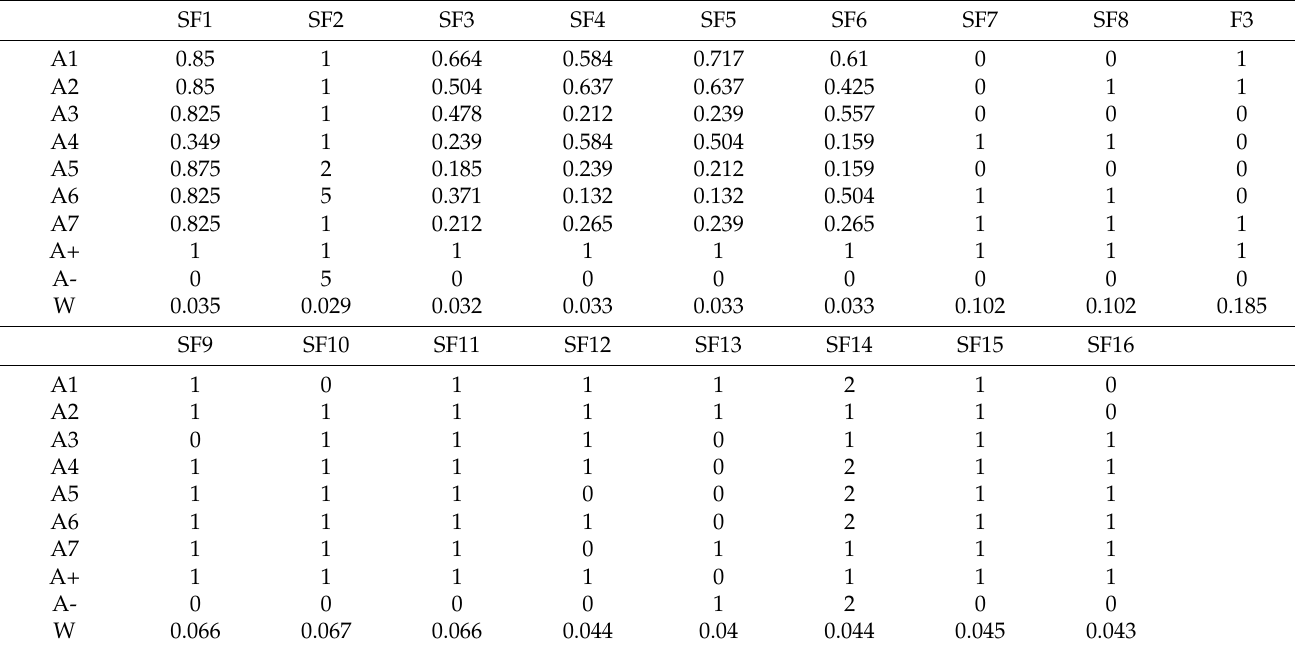
Table A7. The performance matrix in TOPSIS